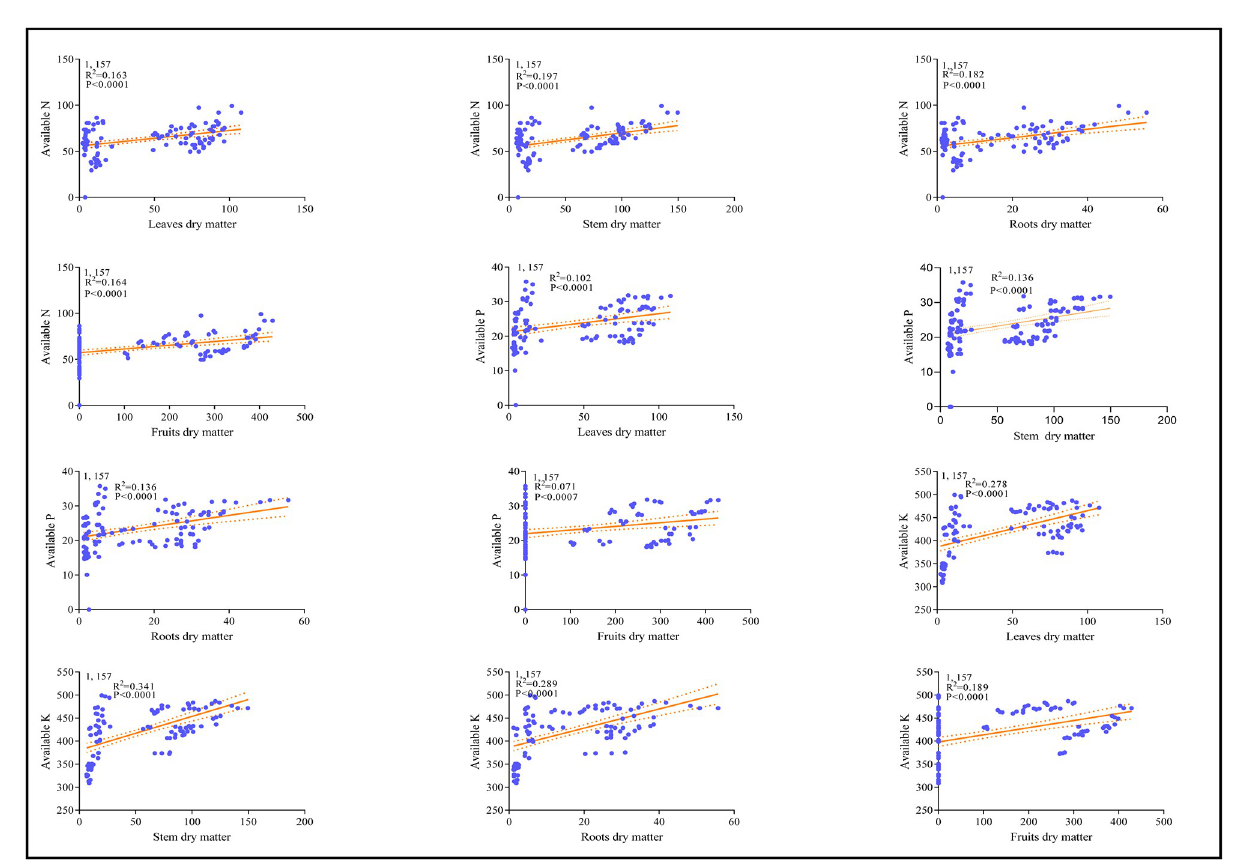
Fig 5. The relationship between soil available nutrients and dry matter in round irrigation (2020).